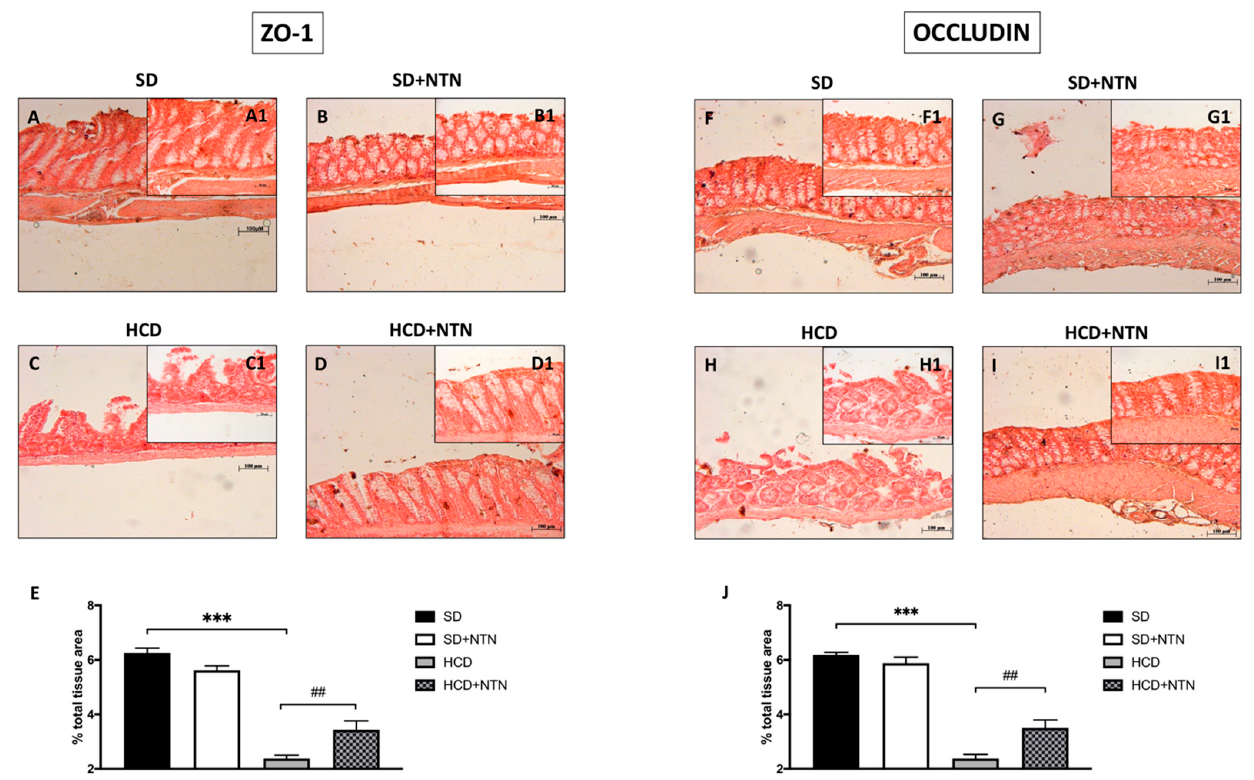
Figure 5. Effects of NTN administration on intestine epithelial integrity in HCD mice. A high percentage in the expression of ZO-1 ( A , B , E ) and Occludin ( F , G , J ) were found in intestinal tissues of SD mice, conversely HCD decreased such expressions ( C , E , H , J ). NTN has appreciably restored the levels of ZO-1 ( D , E ) and Occludin ( I , J ). Data are representative of at least three independent experiments. Values are means ± SEM. One-Way ANOVA test. *** p < 0.001 vs. SD; ## p < 0.01 vs.